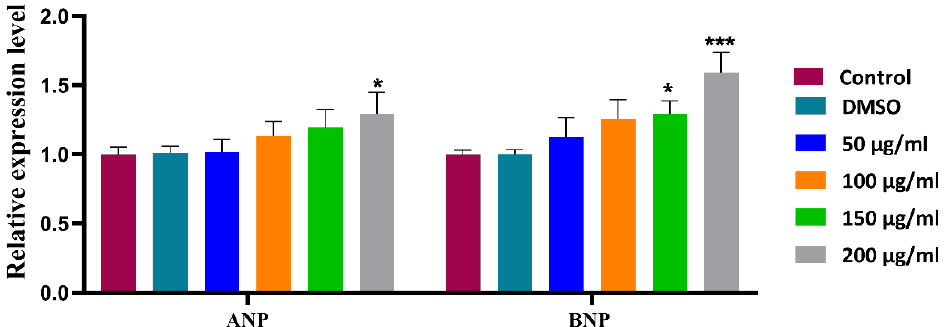
Figure 7. Cardiac failure markers expression of experimental groups at 72 h post-fertilization. All data are presented as mean ± SEM (experiments were carried in triplicate). The analysis was done by two-way ANOVA with Sidak post hoc test. * p < 0.05 and *** p <